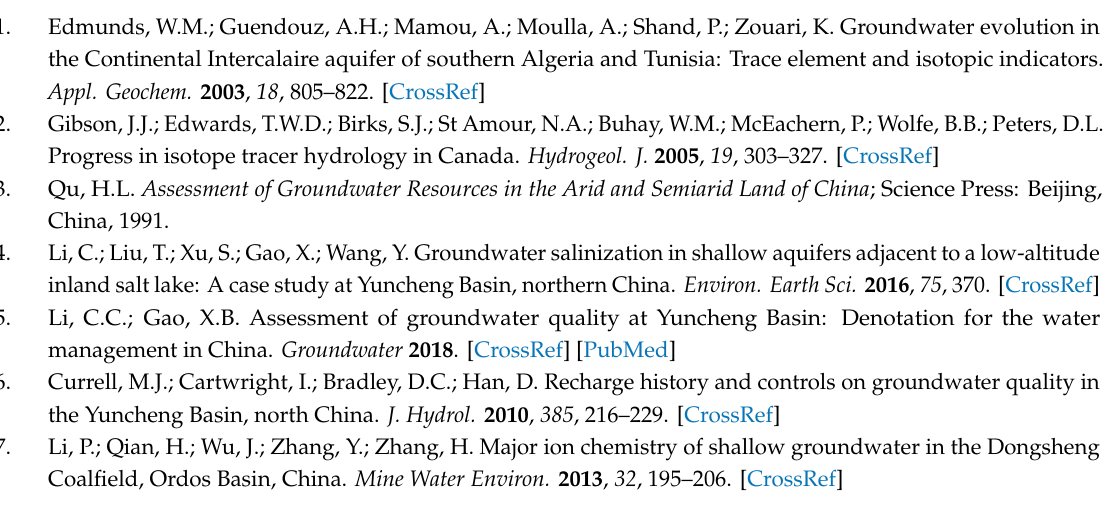
Figure S1. Piper diagram of shallow groundwater samples; Figure S2. Piper diagram of deep groundwater samples; Table S1. Groundwater sample numbers, locations and depths; results of groundwater chemical and isotopic Table S3. Pearson correlation coe ffi cients of major hydrochemical parameter in intermediate-deep groundwater; Table S4. Variance explained by the first three principal components in shallow groundwater samples; Table S5. Variance explained by the first three principal components in intermediate-deep groundwater